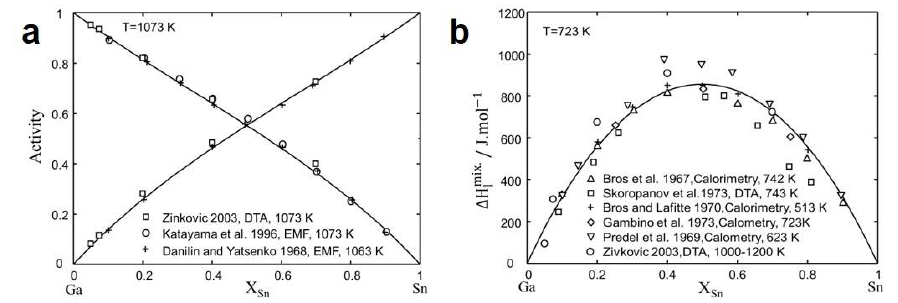
Figure 2. ( a ) Calculated activity of Ga (l) and Sn (l) in liquid at 1073 K along with experimental data from [42,45,46] and ( b ) mixing enthalpy of liquid at 723 K along with experimental data from